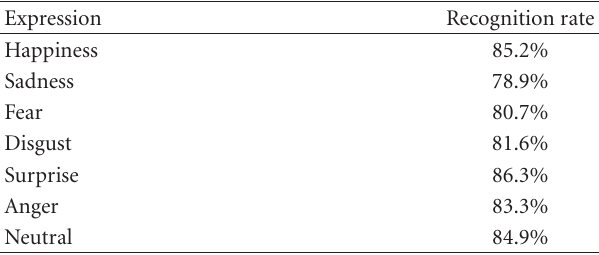
Table 1: Recognition results for 7 expressions classification.